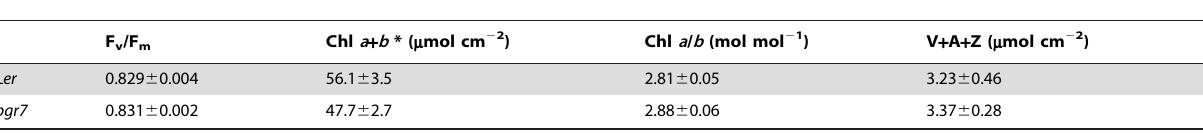
Table 1. Photosynthesis-related Phenotypes of pgr7